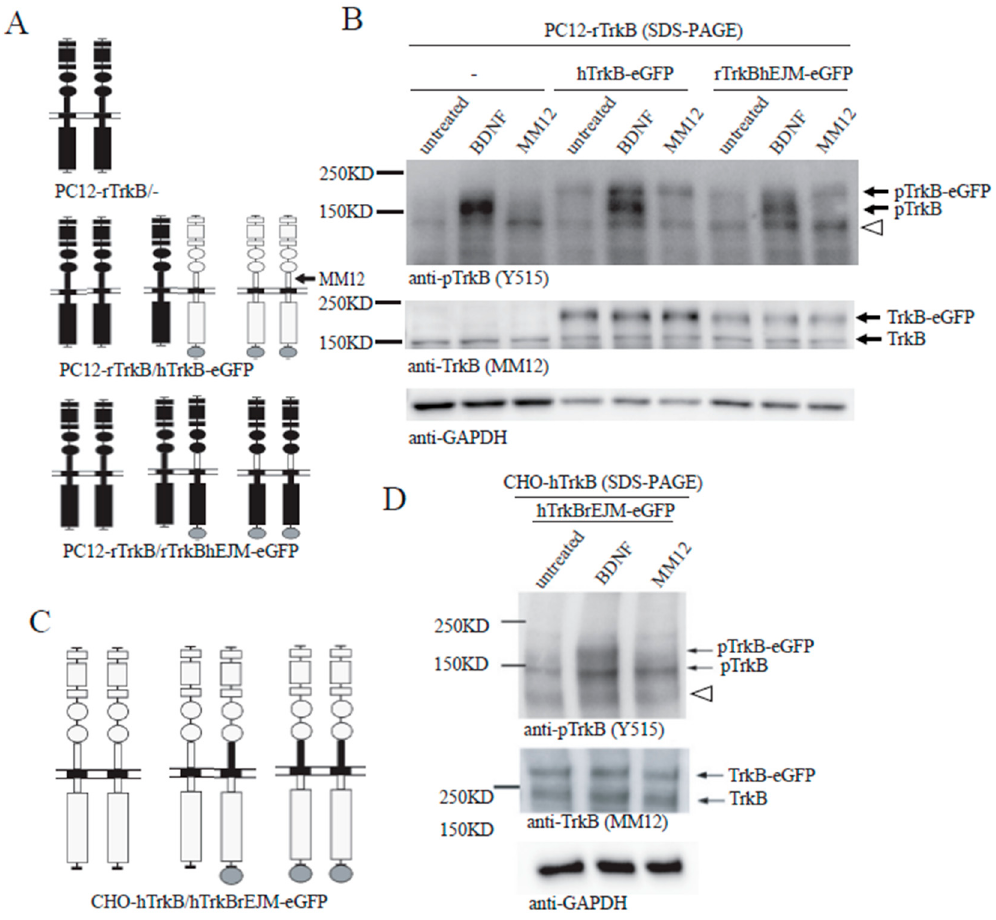
Figure 5. Binding of both monomers with a ligand is required for preformed TrkB dimer activation. ( A ) Schematic diagrams showing homodimer and hetero-dimer in PC12-rTrkB transfected without anything (top), with hTrkB-eGFP (middle) or rTrkBhEJM-eGFP (bottom). ( B ) MM12 selectively activates human TrkB (hTrkB) homodimer and homodimer of rat TrkB (rTrkB) with human EJM (rTrkBhEJM), but not hTrkB-rTrkB hetero-dimer or rTrkB- rTrkBhEJM hetero-dimer. PC12 cells expressing endogenous rTrkB were transfected with hTrkB-eGFP or rTrkBhEJM-eGFP, stimulated with vehicle, BDNF, or MM12 (1.0 nM) for 15 min before harvesting. Cell lysates (2 µ g) were subject to SDS-PAGE and processed for Western blotting. The blots were probed anti-TrkB (Y515) for pTrkB and MM12 for total TrkB. Open triangle points to a non-specific band. ( C ) Schematic diagrams showing hTrkB homodimer (left), hTrkB- rTrkBhEJM-eGFP hetero-dimer (center) and rTrkBhEJM-eGFP homodimer. ( D ) MM12 selectively activates hTrkB, but not a TrkB dimer containing either one or two copies of rEJM. CHO cells were transfected with both hTrkB and hTrkBrEJM-eGFP, stimulated with BDNF or MM12, and then processed for SDS-PAGE and Western blotting the same way as C. Note that MM12 only activate hTrkB homodimer (lower molecular weight band), but not the hTrkBrEJM-eGFP containing hetero- or homo- dimers (higher molecular weight band). Open triangle points to a non-specific band. Each experiment was repeated